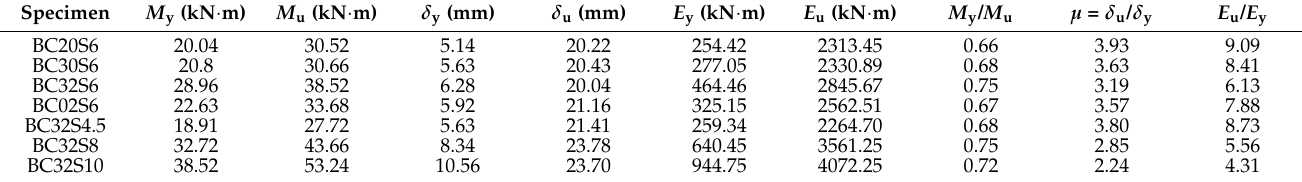
Table 5. Ductility and energy dissipation indexes of CA-UHPCFSTs under bending.